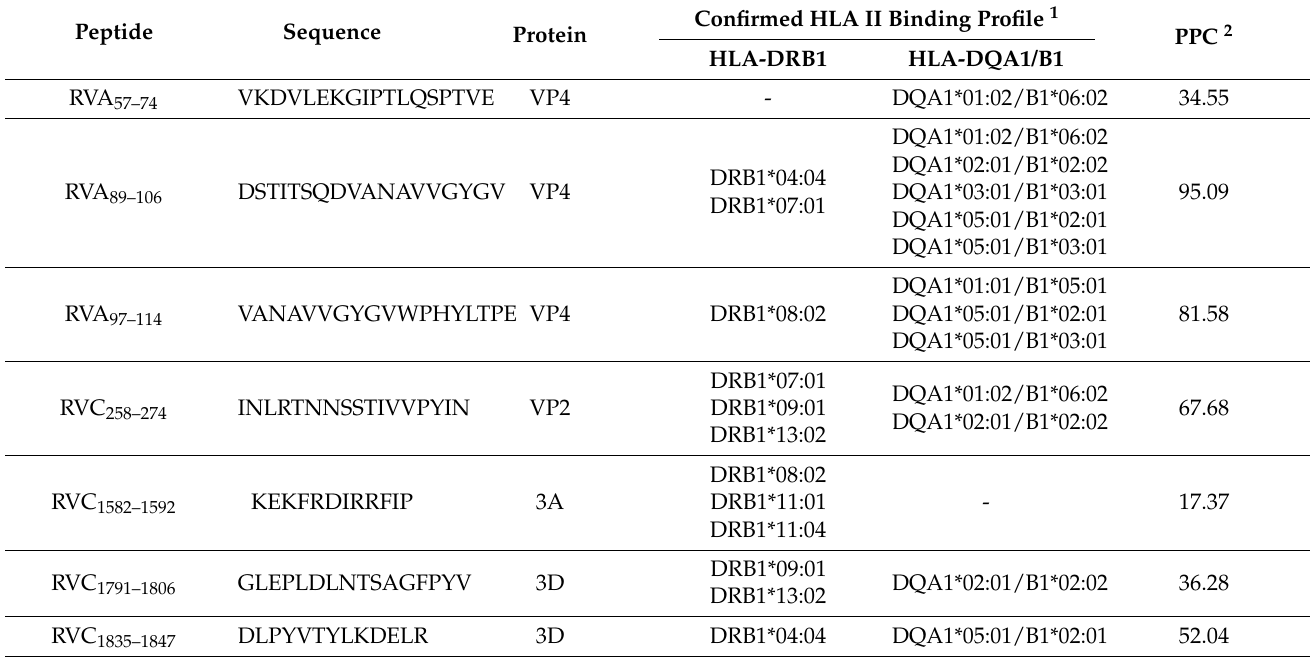
Table 2. Summary of the RV-specific CD4 T cell epitopes identified in this